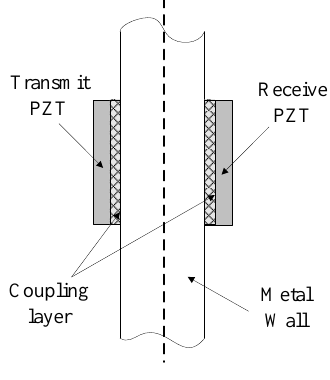
Figure 5. Diagram of PT channel formed by a pair of piezoelectric transducers.